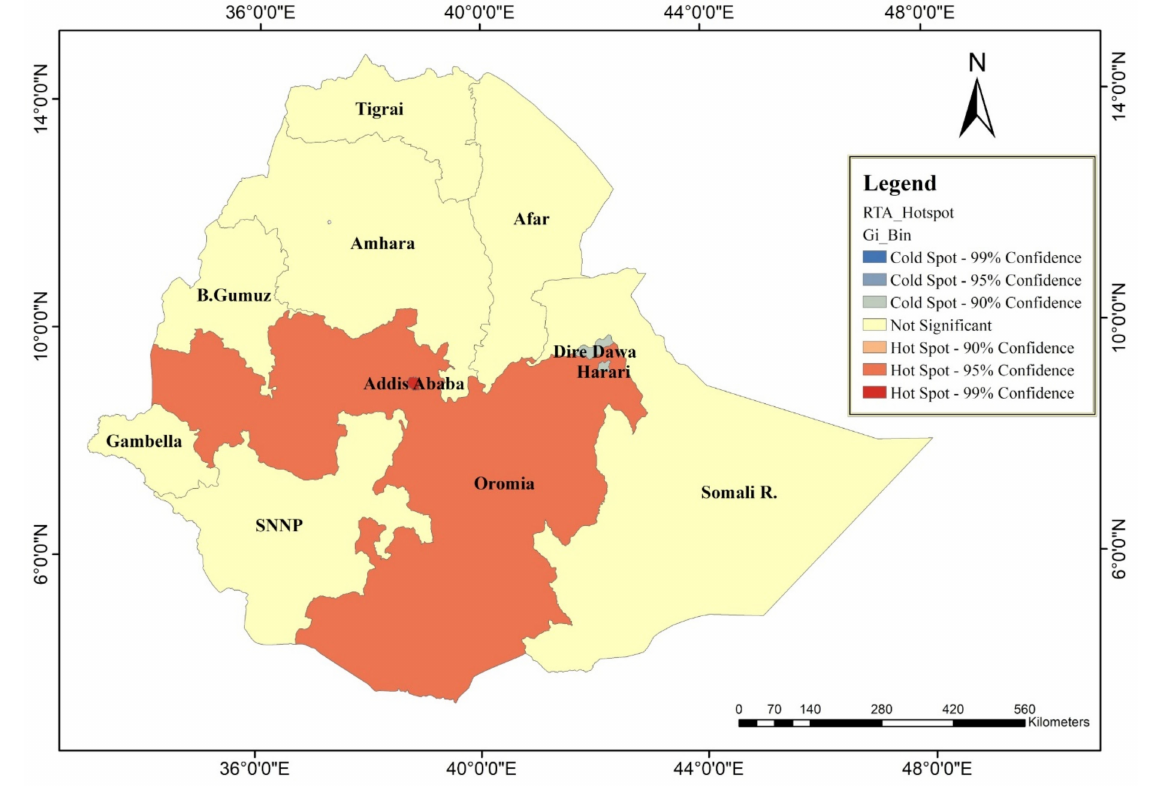
Figure 3. ( a ) Result of spatial autocorrelation; ( b ) Attribute table result of spatial autocorrelation.